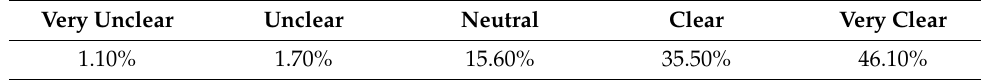
Table 7. Obtained values of classifying other descriptions.